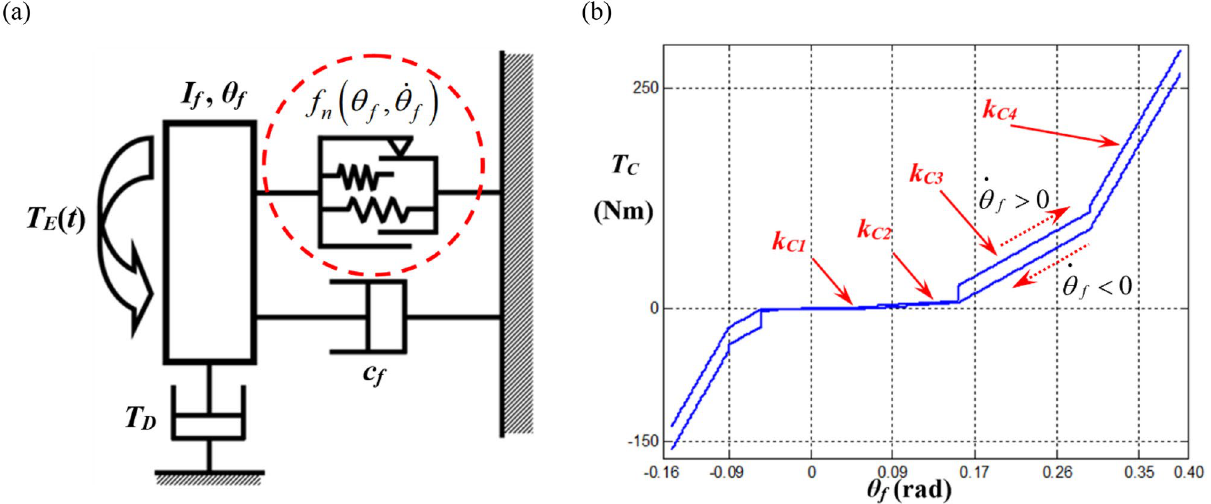
Figure 1. Torsional system with 1DOF affected by piecewise-type nonlinearities: ( a ) a nonlinear torsional system based on physical clutch dampers; ( b ) an asymmetric torque T C ( δ 1 ) profile induced by multi-staged clutch dampers 17,28